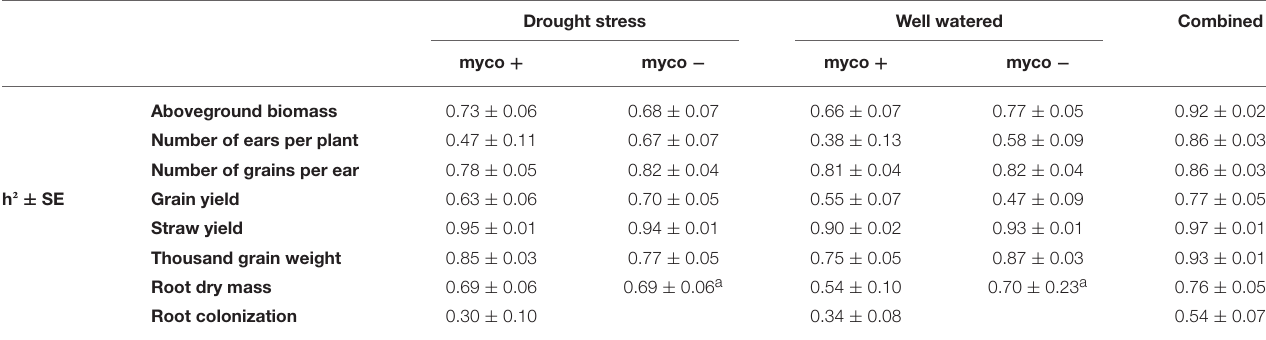
TABLE 2 | Estimated heritabilities (h ² ) of aboveground biomass (BM), number of ears per plant (EN), number of grains per ear (GN), grain yield (GY), straw yield (SY), thousand grain weight (TGW), root dry mass (RM), and root colonization by mycorrhizal fungi under drought stress and well watered conditions in the presence (myco + ) and absence (myco − ) of mycorrhizae and across all environments (combined) for 94 wheat genotypes evaluated in 2 years. Drought